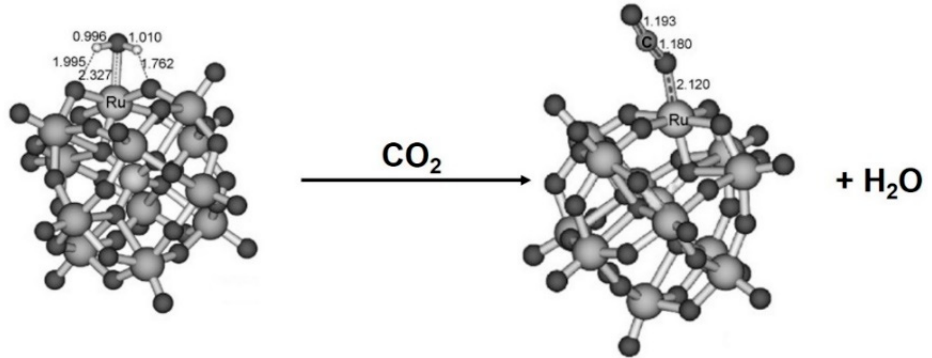
Figure 3. The substitution of H 2 O with CO 2 in [Ru III (H 2 O)SiW 11 O 39 ] 5– . Reprinted with permission from [40]. Copyright © 2010 Wiley-VCH Verlag GmbH and Co. KGaA.